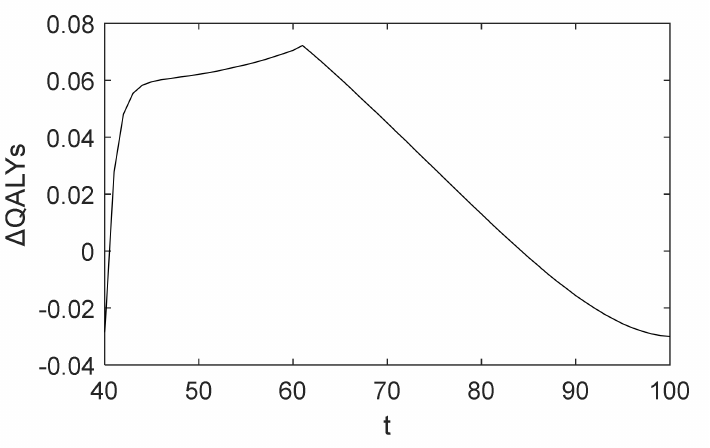
Figure 4. ∆ QALYs in baseline